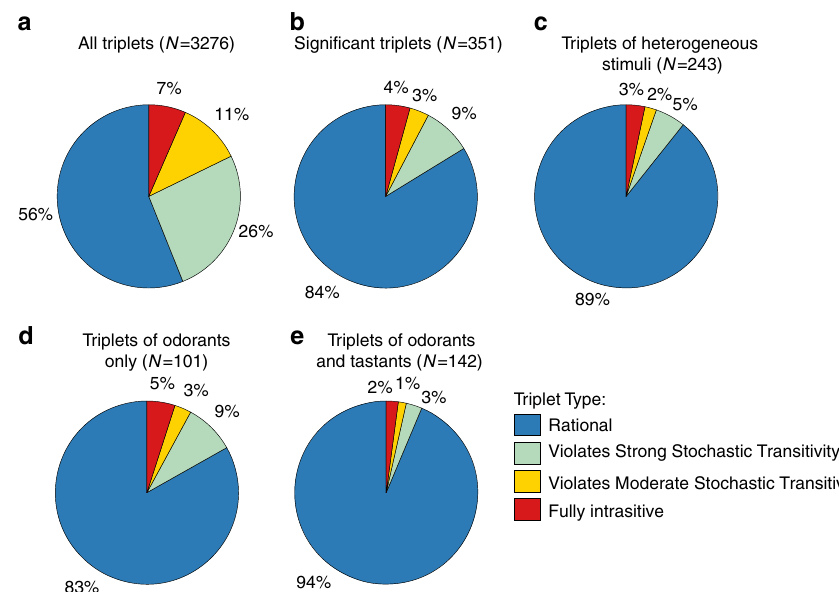
Fig. 3 Intransitivity is more prevalent when considering options sensed by a single modality. a Classi fi cation into (in)transitive types of all possible 3276 triplets. b Classi fi cation of triplets for which signi fi cance could be assigned (con fi dence interval is > 95%, see methods for calculation details). c Out of the 351 signi fi cant triplets, shown are the classi fi cations of heterogeneous triplets (e.g., consisted of three different stimuli). d – e Of the 243 heterogeneous triplets in c , 101 were consisted of odorants only d , and 142 were consisted of at least one tastant and one odorant e . The proportion of triplets that violate transitivity (of any type) in d , is signi fi cantly larger than in e , indicating that intransitivity is more common when considering odorants only than a mixture of odorants and tastants ( P = 0.009, Χ 2 test, N =